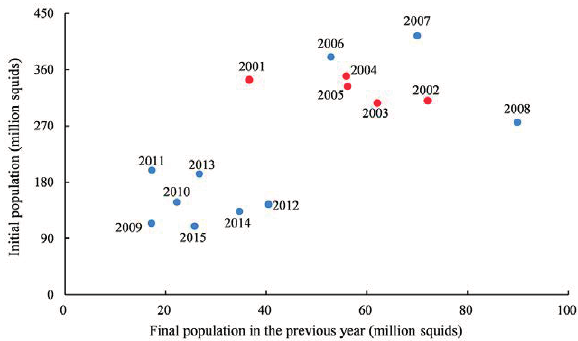
Fig. 8. – Relationships between initial abundance of the current year and final abundance of the previous year (million individuals) of the western winter-spring stock of Ommastrephes bartramii. [Blue dots represent the estimates from the DeLury depletion model based on M =0.007 per day and red dots are estimates from Chen et al. (2008a)].